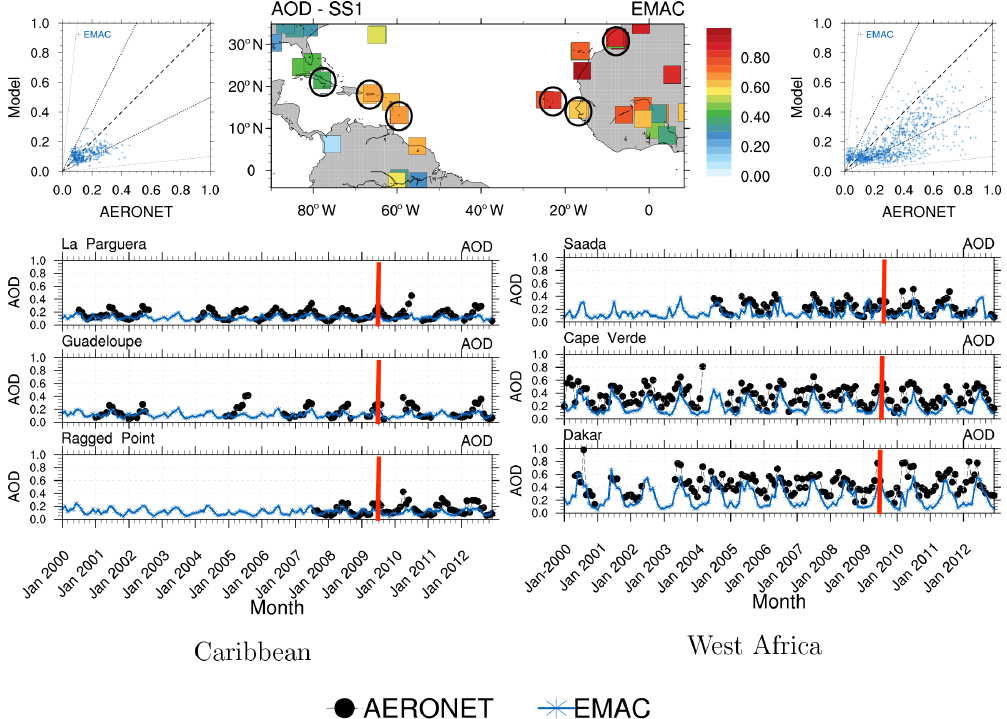
Figure 4. The long-term evaluation of AOD (2000–2012) over western Africa and the Caribbean. The top panel represents scatter plots including all observations from all stations (left for the Caribbean, right for the western African region) and the skill score (SS1) as defined in Appendix A. The lower panel depicts a time series for stations in both regions (monthly means of 5h averages for the model and AERONET AOD). The red bars represent the July 2009 dust outflow period, and the black circles depict the selected AERONET stations shown in Fig. 3 within observations for the period of our sensitivity simulations. The dotted lines in the scatter plot show the 1 : 2 and 1 : 10